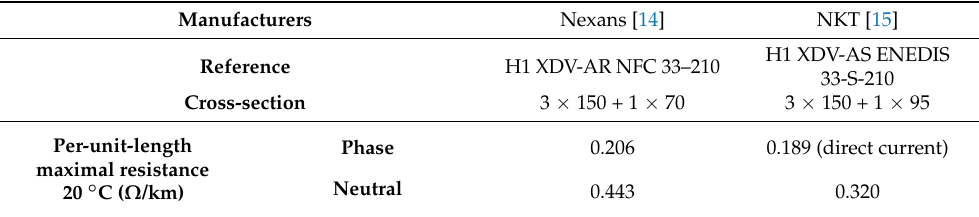
Table 7. Characteristics of French LV cable given by manufacturers.